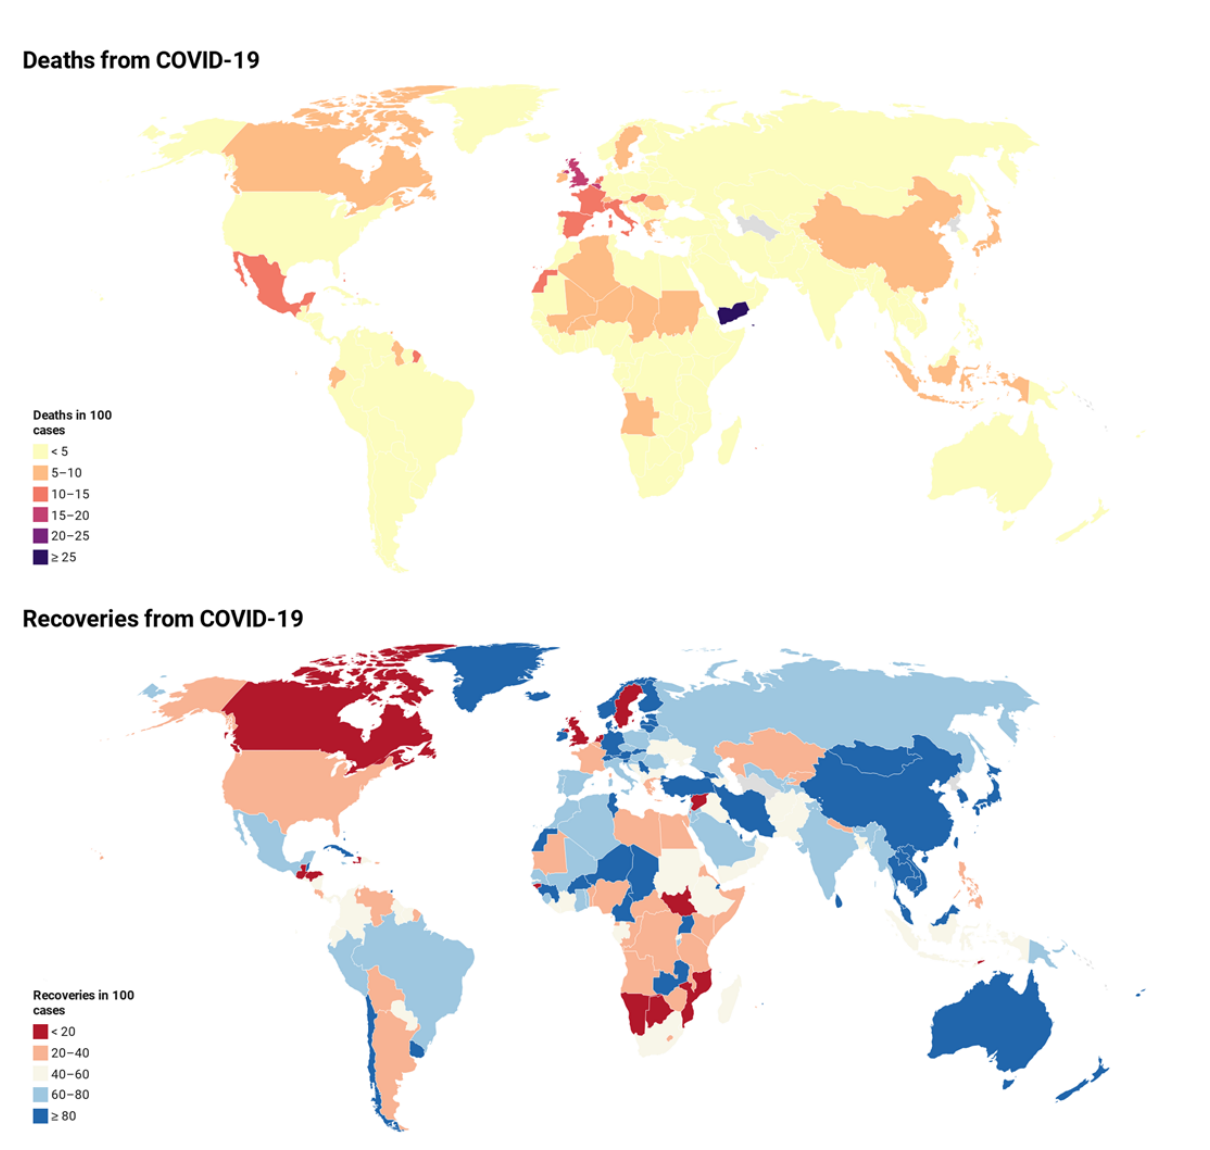
Figure 1. World map related to the number of deaths (top) and the number of recoveries (bottom) in 100 cases of COVID-19 as of July 3,